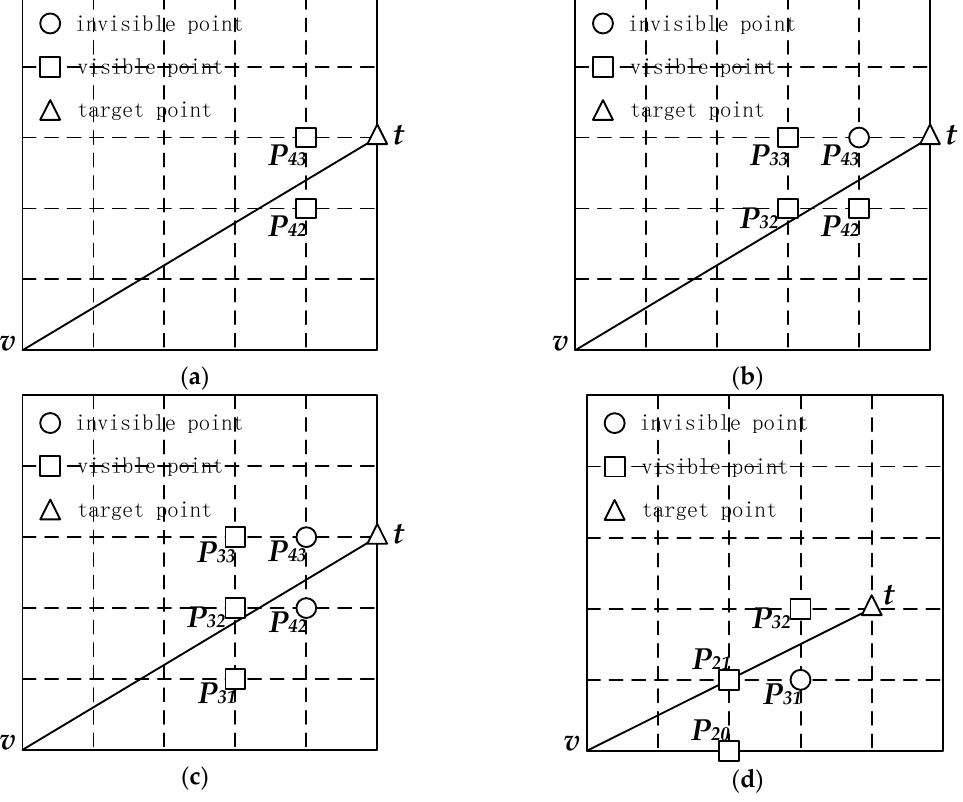
Figure 4. The number of contributing points. v is the viewpoint. t is the target point. A rectangle point represents a visible point and a round point represents an invisible point. ( a ) t ’s two reference points, P 42 and P 43 , are both visible. t has two contributing points: P 42 and P 43 ; ( b ) one of t ’s reference points, P 43 , is invisible. Suppose the contributing points of P 43 are P 33 and P 32 . t has three contributing points: P 42 , P 32 and P 33 ; ( c ) t ’s two reference points, P 43 and P 42 , are both invisible. Suppose the contributing points of P 43 is P 33 and P 32 . Suppose the contributing points of P 42 is P 32 and P 31 . P 43 and P 42 share a common contributing point P 32 . t has three contributing points: P 31 , P 32 and P 33 ; ( d ) one of t ’s reference points P 31 is invisible. Suppose the contributing points of P 31 is P 21 and P 20 . t has three contributing points: P 20 , P 21 and P 32 . P 21 lies right on the LOS of t ;